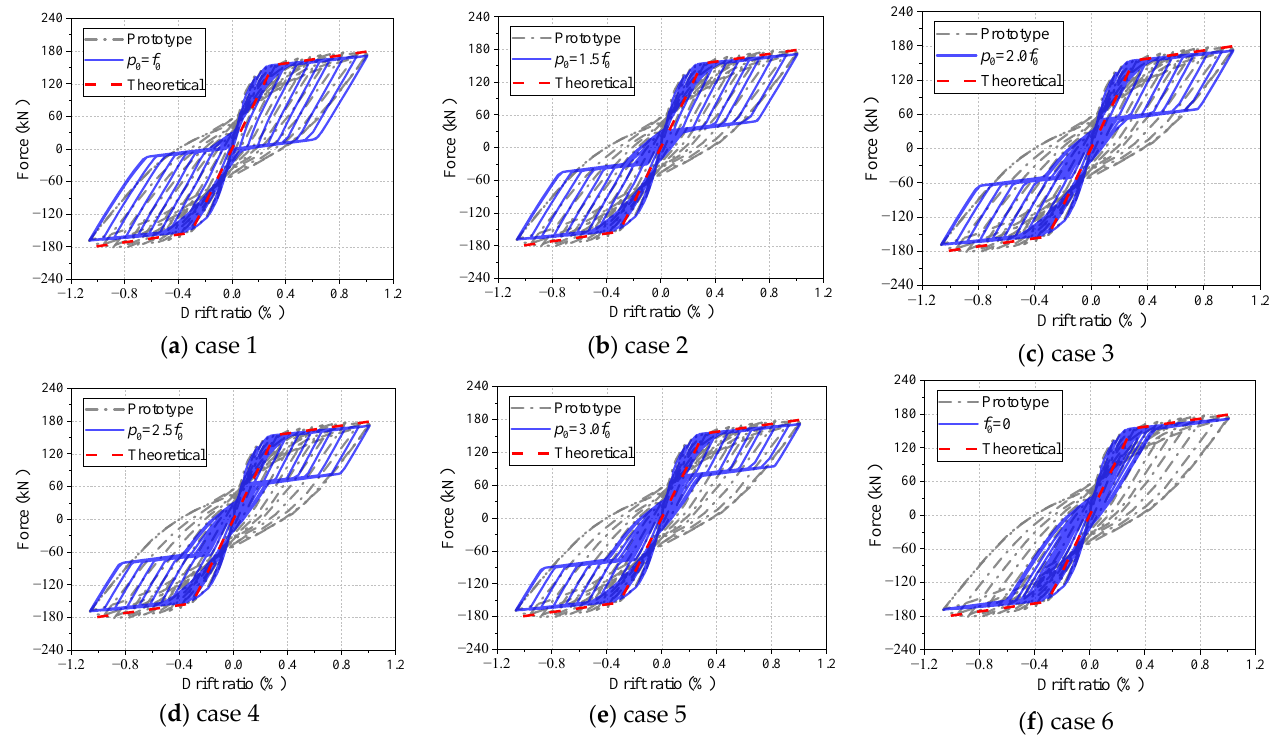
Figure 8. Hysteretic curve of the numerical cases.